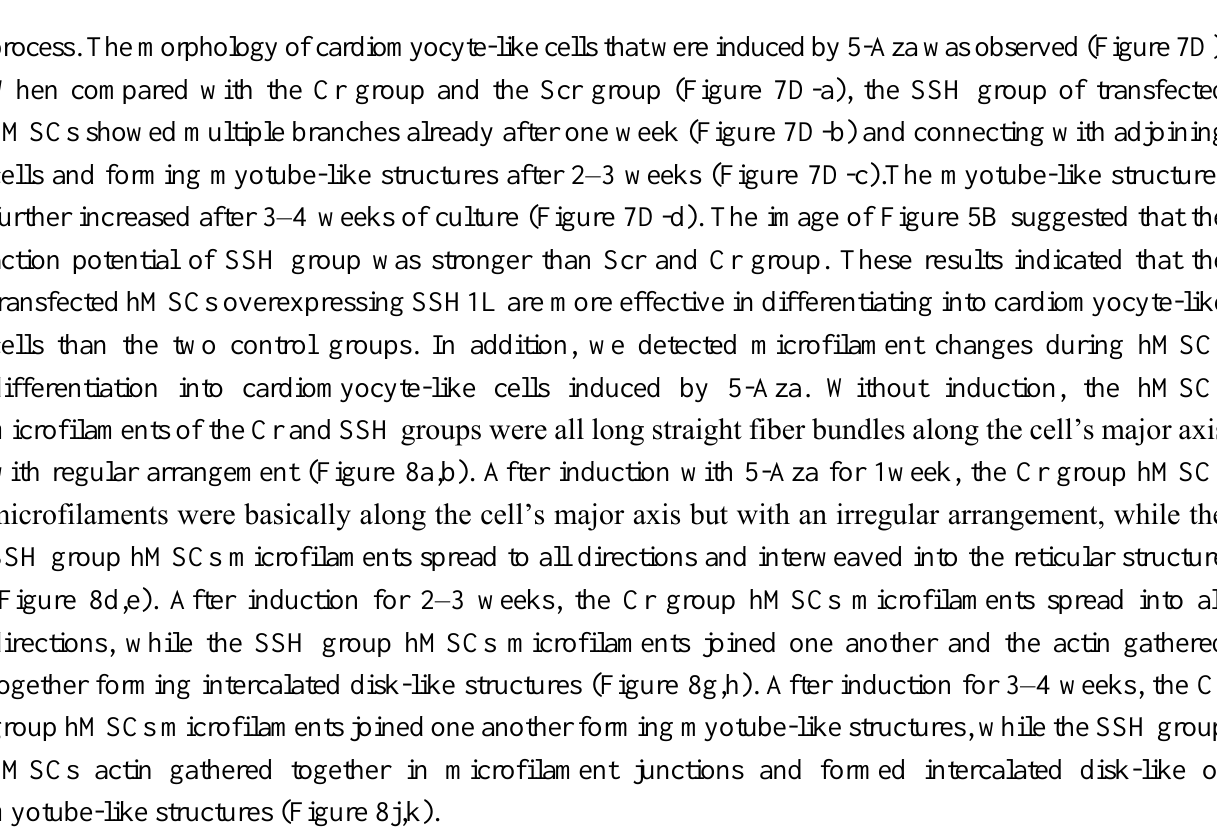
Figure 6. Immunocytochemical staining analysis of cardiac-specific protein expression after 5-Aza treatment. ( A ) Immunocytochemical staining of CM-specific proteins such as cTnI (upper panels), desmin(middle panels), and α-sarcomeric actin(lower panels) by inverted microscopy. The positive rates were shown in ( B ). a, e, and i were controls; b, f, and j were treated with 5-Aza for 1 week; c, g, and k for 2 weeks; d, h, and l for 3–4 weeks. Scale bar, 50